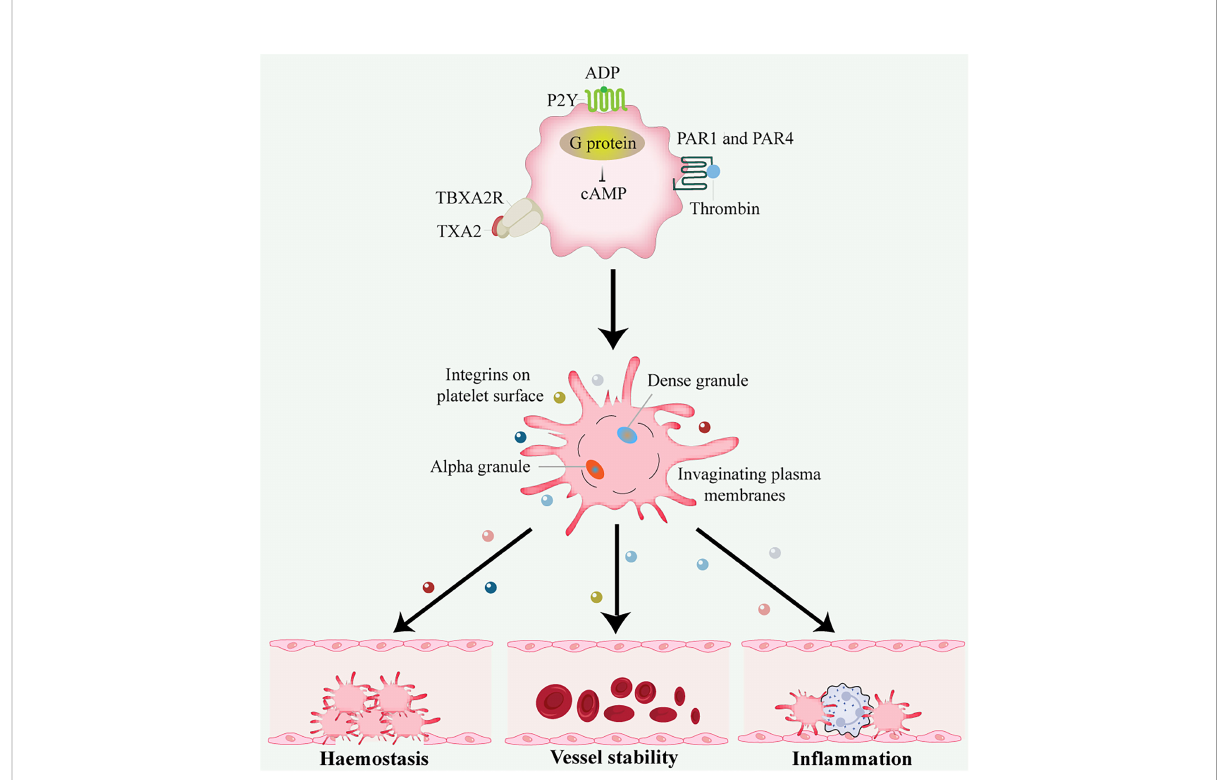
FIGURE 1 Platelet activation and function. Thrombin activates G protein-associated PARs on the platelet surface during platelet activation, triggering intracellular calcium fl ux and cAMP reduction. Other platelet activators include subendothelial matrix collagen, ADP, and TXA2 exposed during vascular injury. TXA2 binds to the G protein-coupled receptors P2Y and TBXA2 receptor, stimulating platelet degranulation and release of their contents. Platelets are important in hemostasis and thrombosis, in fl ammation, wound healing, immune responses, angiogenesis, and vessel stability. ADP, adenosine disphosphate; cAMP, cyclic adenosine monophosphate; PAR, protease-activated receptor; TXA2, thromboxane